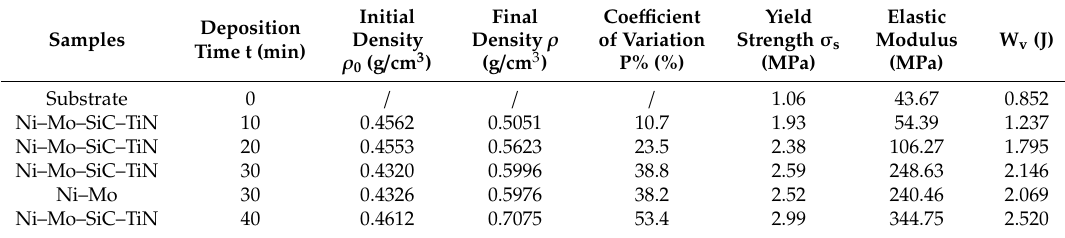
Table 3. Characteristics of di ff erent